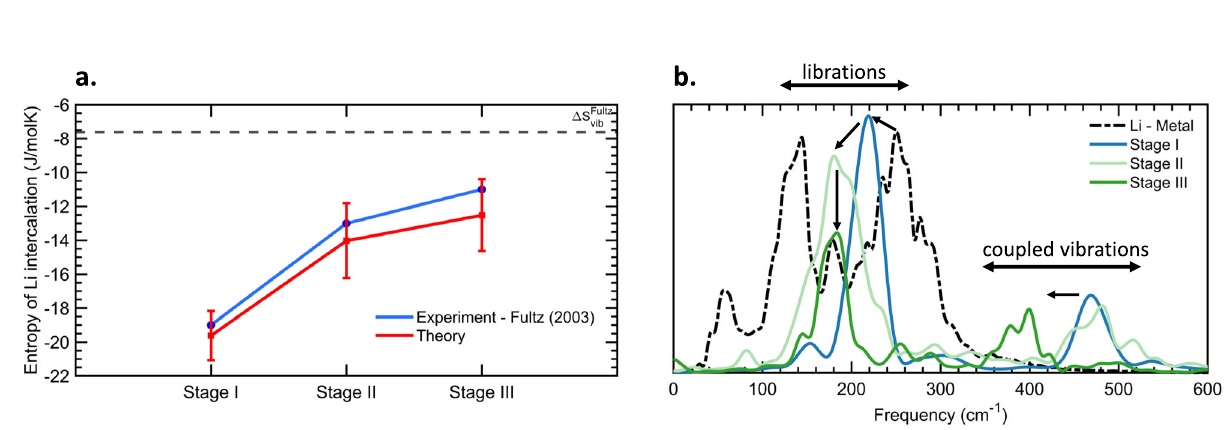
Fig. 4 | Thermodynamics ofstagedLi-GICs. a The entropy ofLi intercalation into Li-GICs, relative to Lithium metal. Our calculated values from 298K AIMD simula- tion(red)arecomparedtotheexperiments(blue).Theerrorbarsonthecalculated values represent the uncertainty (standard deviation 1 σ ). The calculated entropy